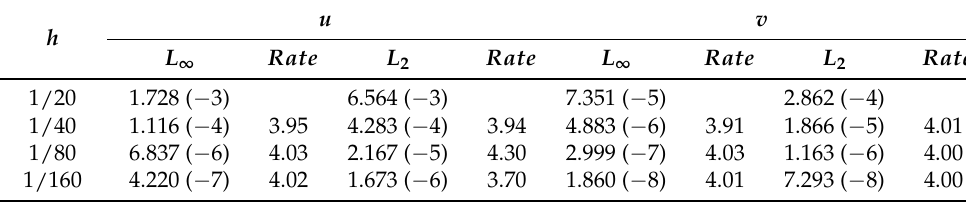
Table 4. The L ∞ error, L 2 error and convergence rate when a = 1, b = 0.01, s = 0.1, d = 0.001 for Problem 3.